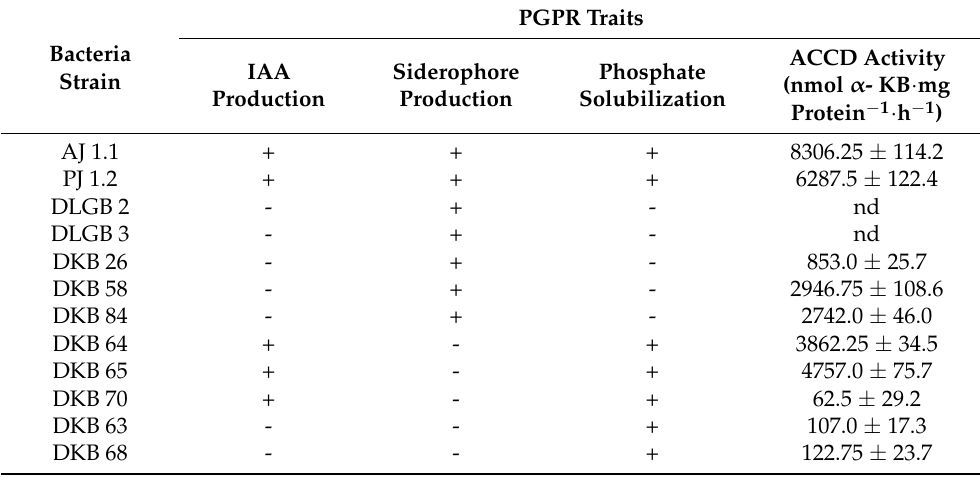
Table 1. Some of the key traits of plant growth-promoting bacteria